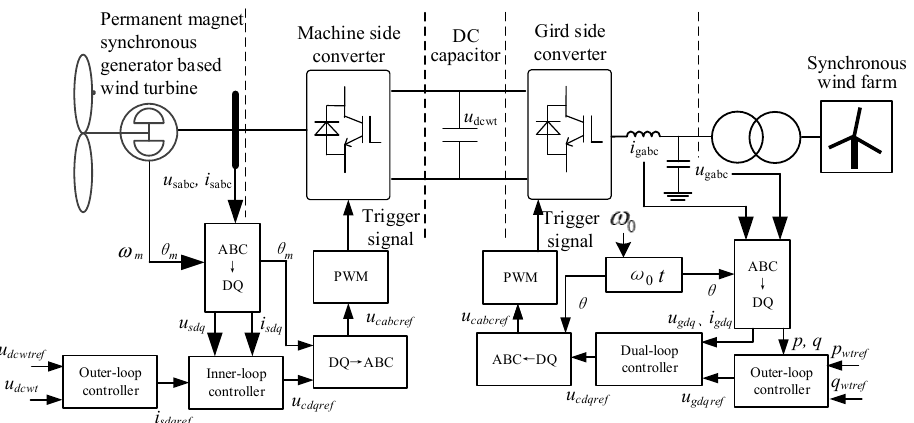
Figure 6. Scheme 5: Low-frequency AC transmission scheme for low-frequency grid-forming off- shore wind farms.